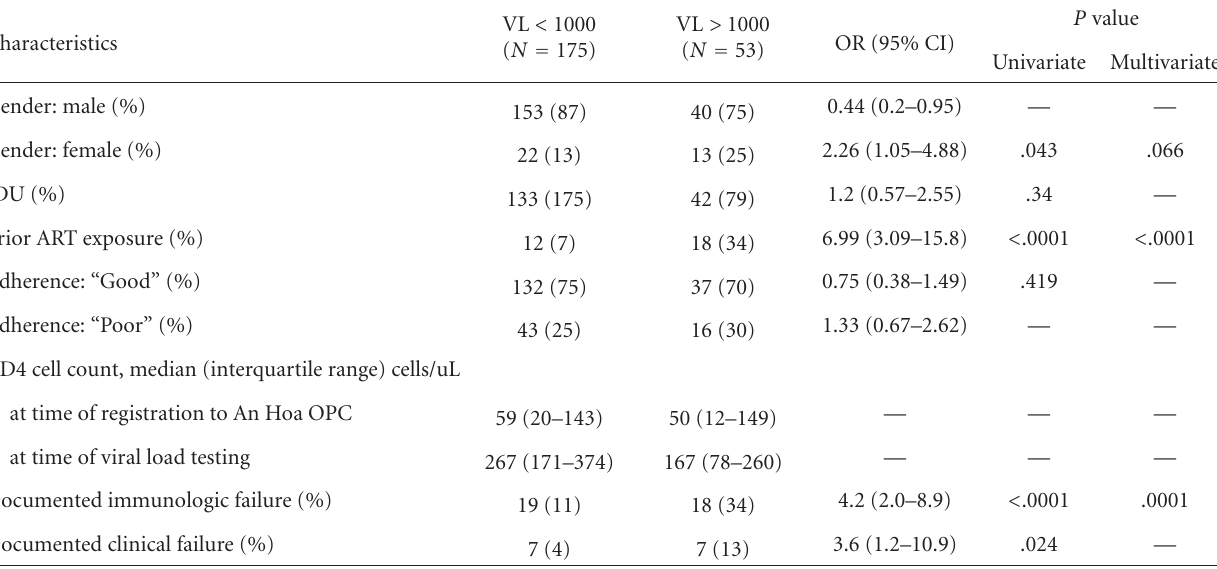
Table 2: Characteristics of patients on ART > 1 year according to result of VL testing, threshold VL 1000 copies/mL.